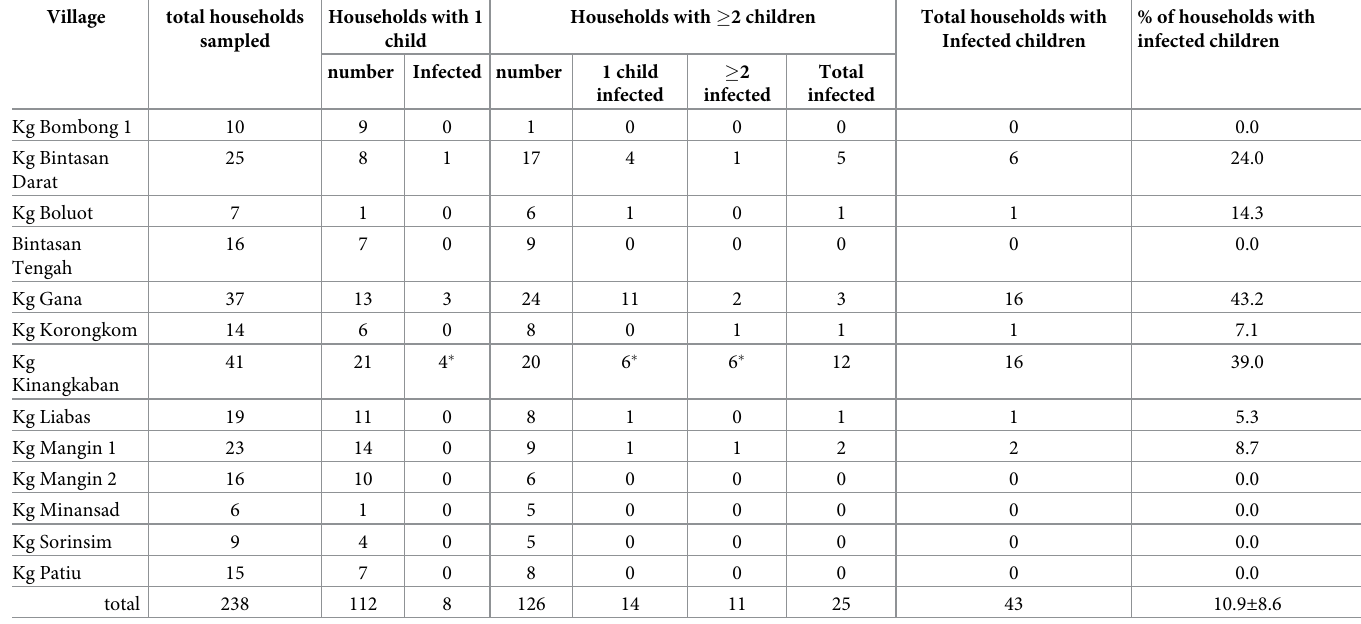
Table 5. Geohelminthiasis prevalence among the children within each